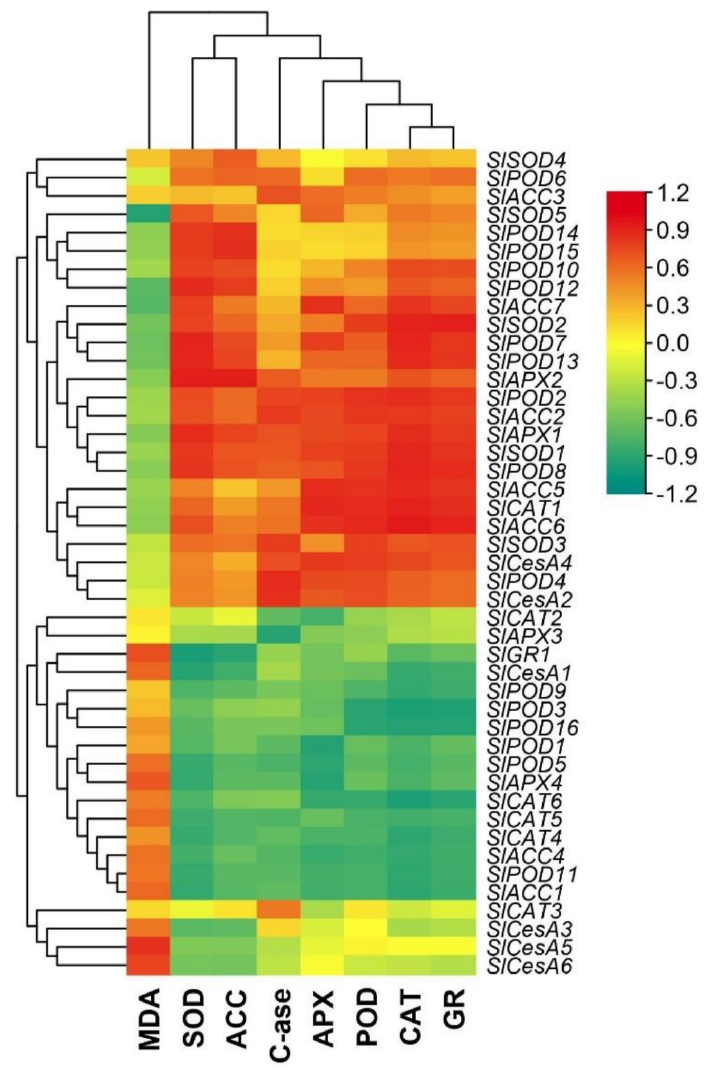
Figure 12. The heat map showing Pearson ( n ) correlation between root-softening enzymes ac- tivities and transcript profiling of their metabolism-related genes. Correlation coefficient values were determined with Pearson ( n ) method using IBM SPSS software (ver. 17.0) and visualized through a heat-map using TBtools software (ver. 0.6655). Color codes: red–higher correlation; green–lower